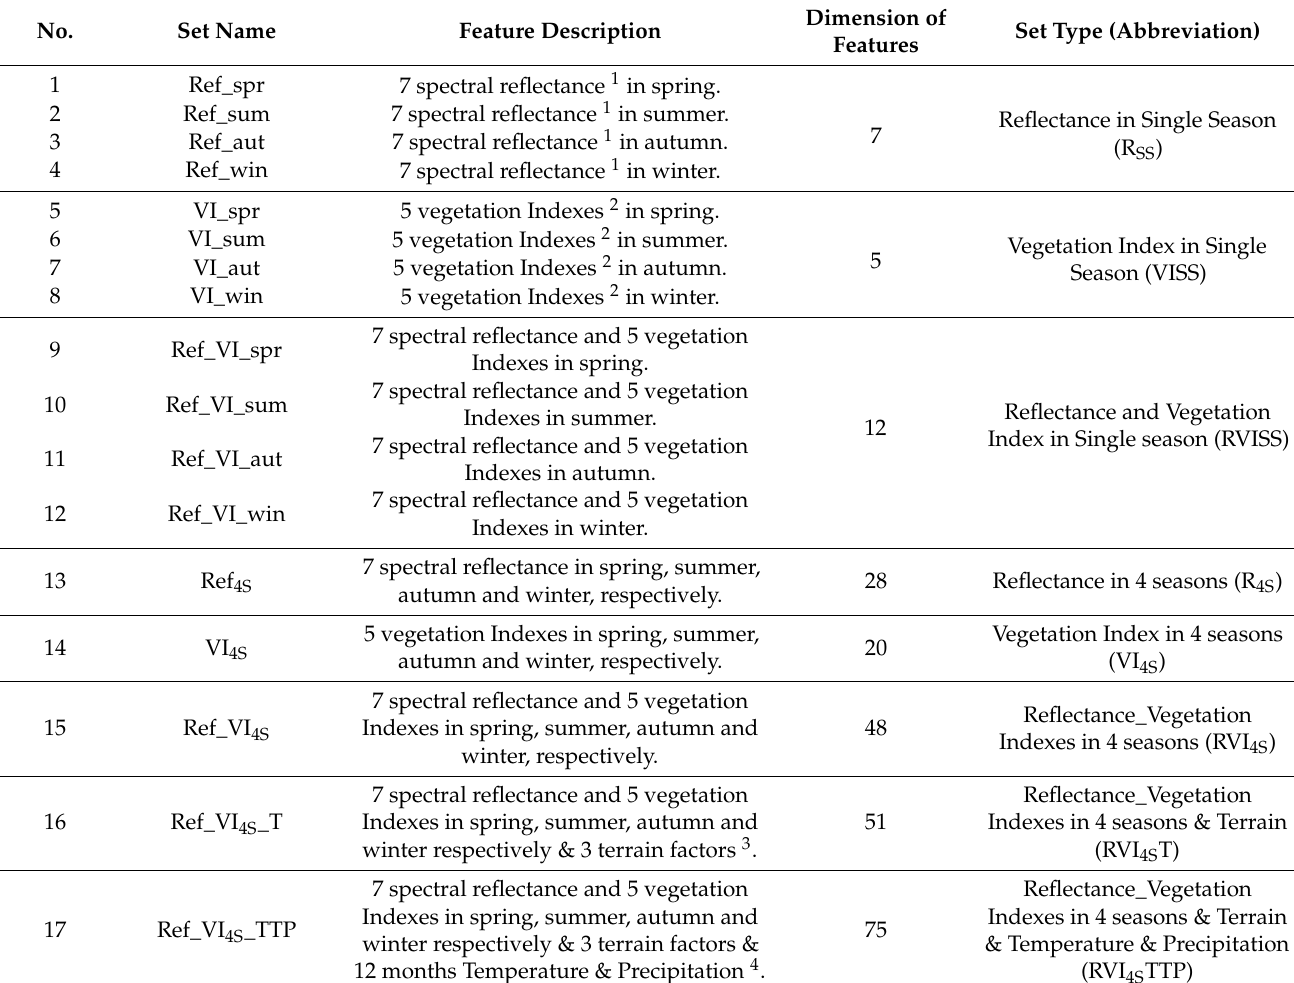
Table 6. The 17 feature combinations for RF classification